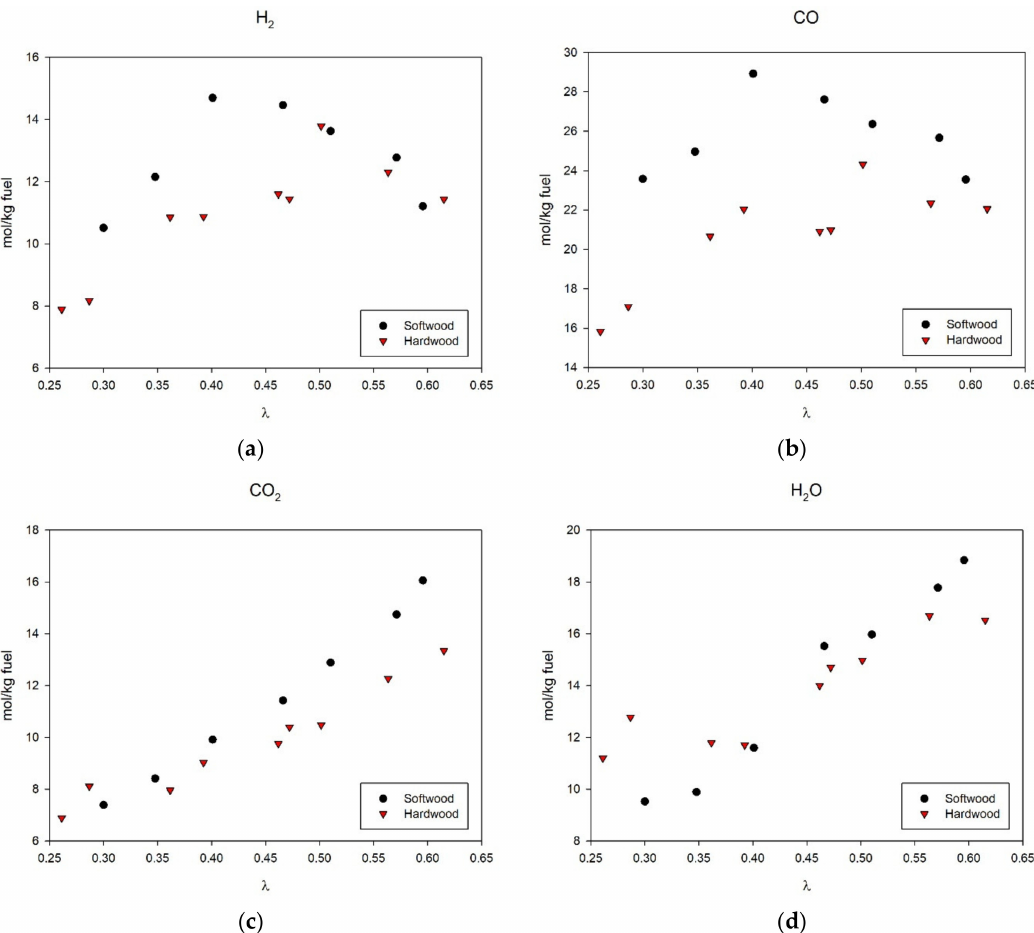
Figure 4. Gas yields (mol/kg fuel) of the major syngas components ( a ) H 2 , ( b ) CO, ( c ) CO 2 , and ( d ) H 2 O as functions of λ